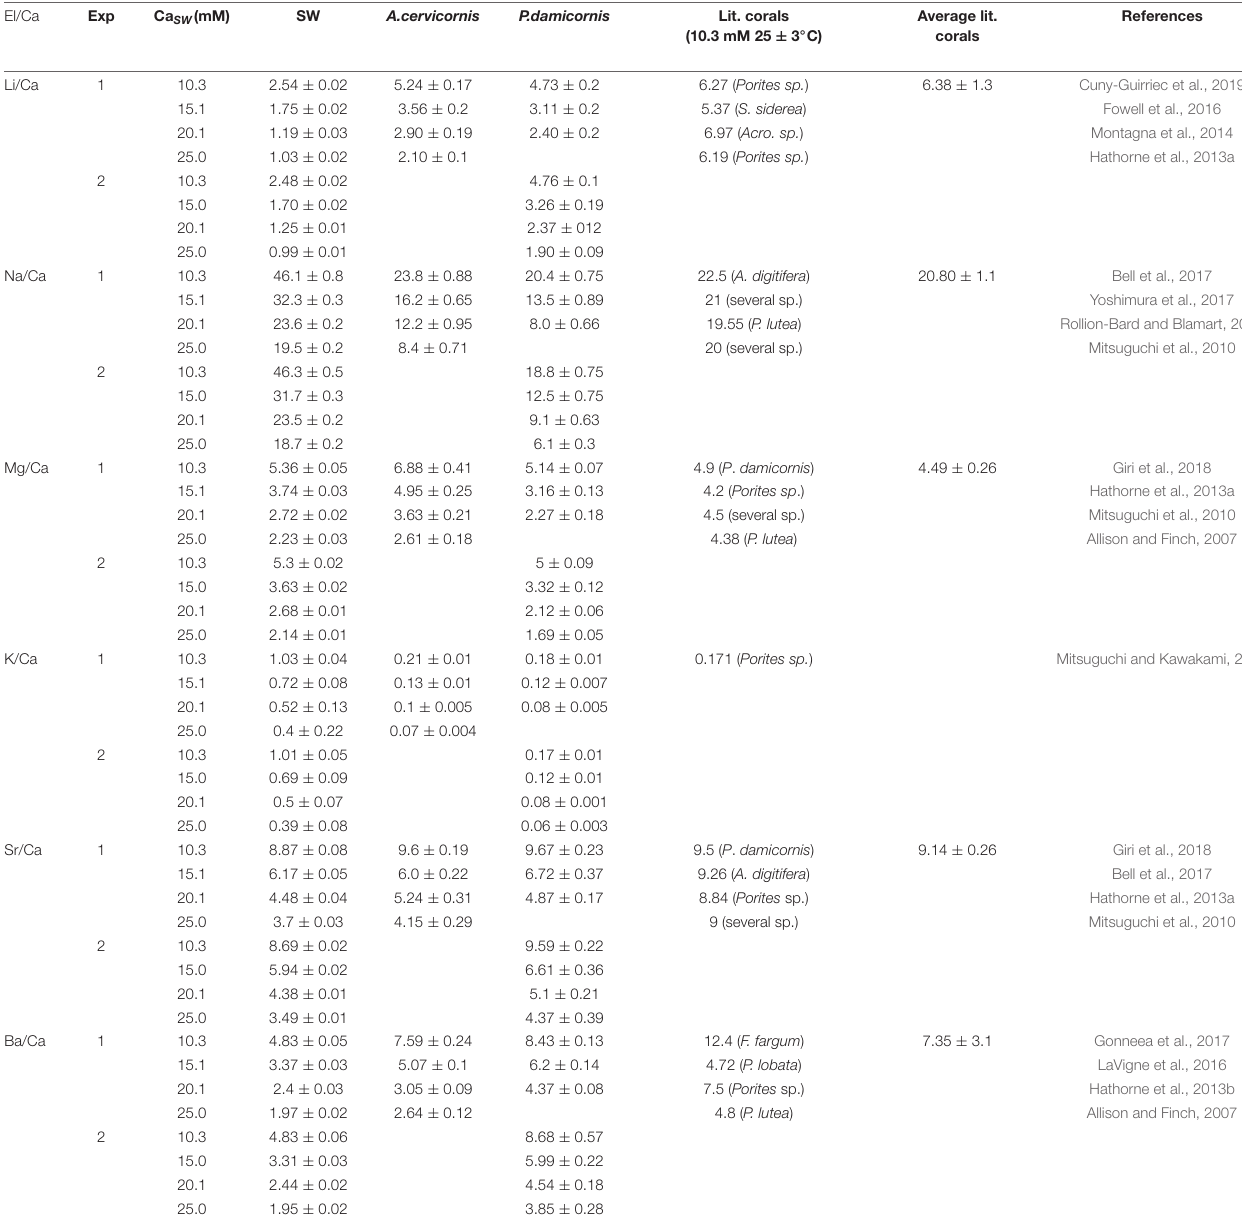
TABLE 2 | El/Ca ratios in SW, new skeleton precipitated under the experimental conditions and the comparison to reported ratios in the literature. El/Ca Exp Ca SW